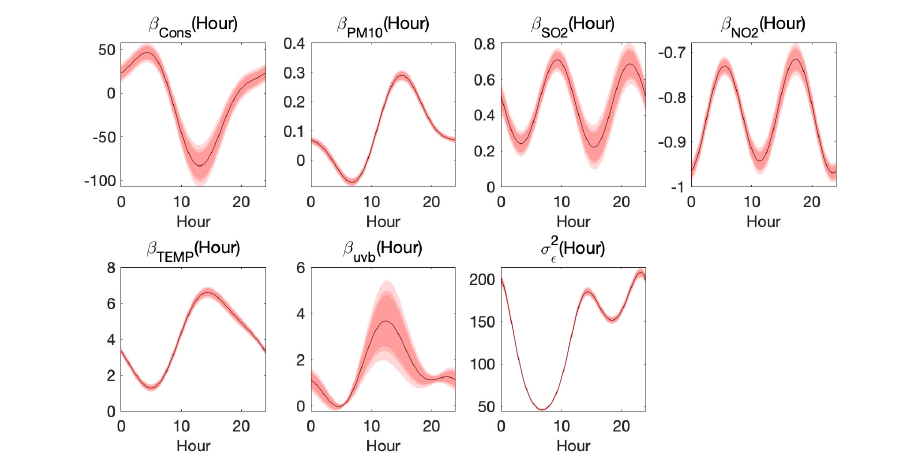
Figure 7. Estimated β cons ( hour ) , β PM 10 ( hour ) , β SO 2 ( hour ) , β NO 2 ( hour ) , β TEMP ( hour ) , β UVB ( hour ) and σ 2 (cid:101) ( hour ) , with 90%,95%,and 99%- confidence